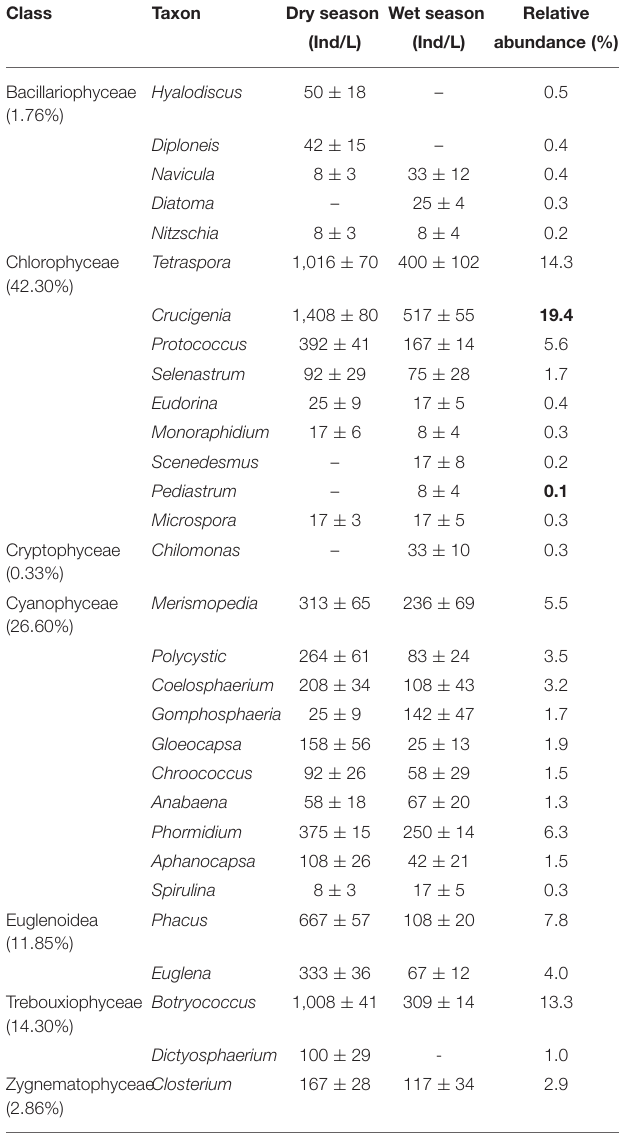
TABLE 3 | Mean ( ± SD) abundance of different phytoplankton taxa recorded in Lake Kanyaboli during the study period from February 2020 to February